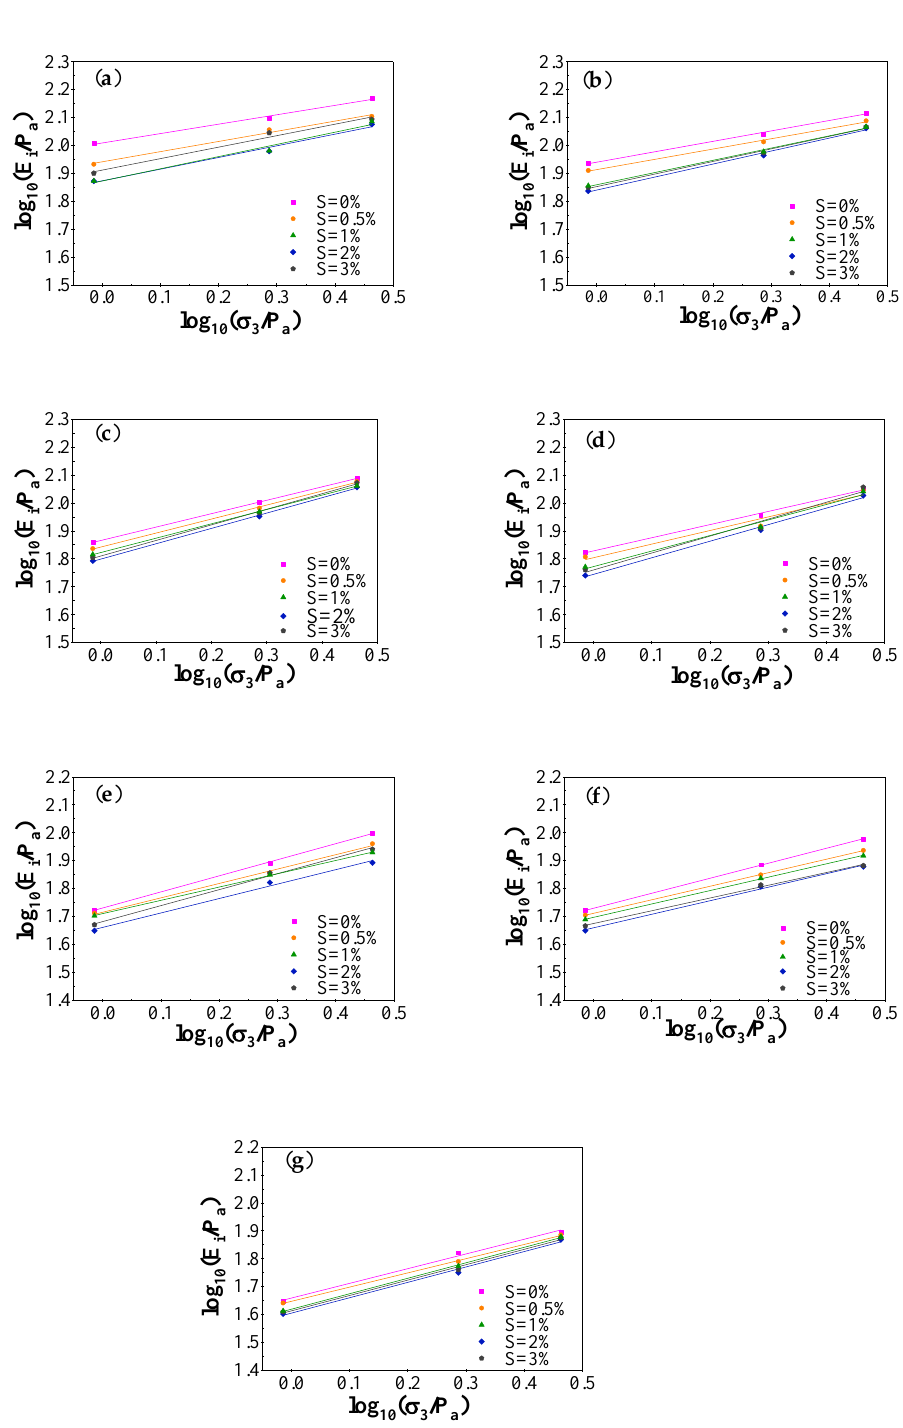
Figure 7. Drawing curves log 10 ( σ 3 / P a )-log 10 (E i / P a ) to obtain parameters log 10 (K) and N: ( a ) FTC = 0; ( b ) FTC = 1; ( c ) FTC = 5; ( d ) FTC = 10; ( e ) FTC = 30; ( f ) FTC = 60; ( g ) FTC = 120.